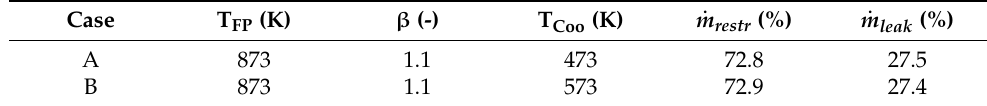
Table 7. Set up values and Flow Path (FP) mass flow rate split.